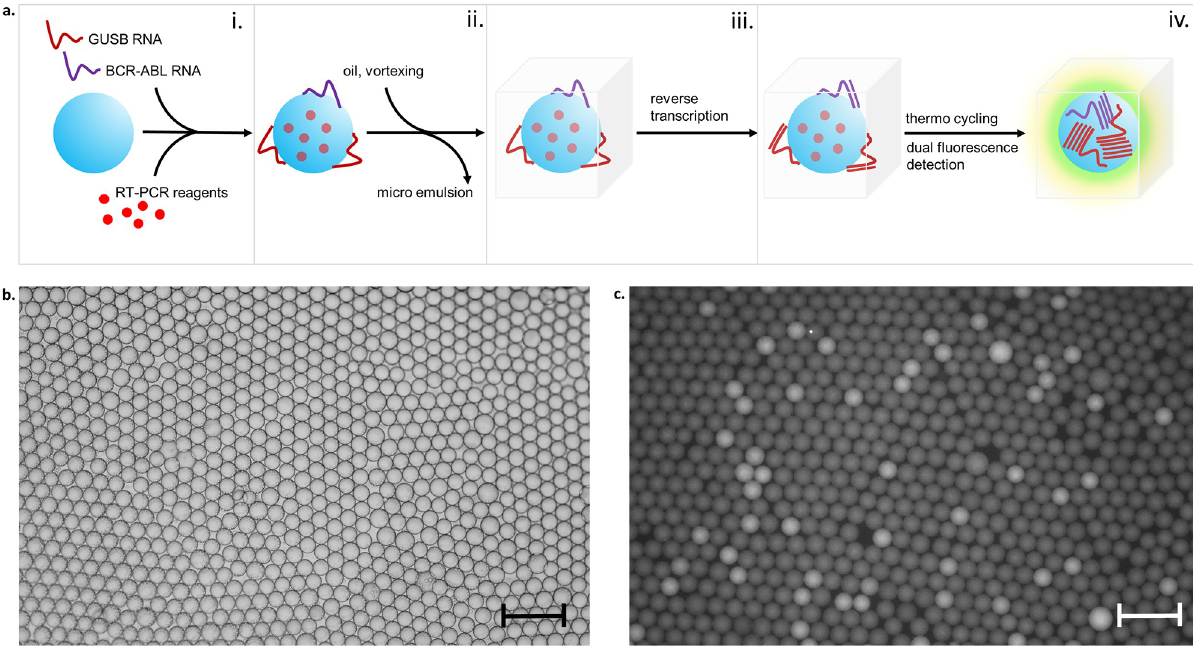
Fig 1. Nanoreactor bead workflow. a, Process steps: i.) nanoreactor bead loading with a solution containing amplification reagents and the extracted nucleic acid, ii.) bead transfer to non-aqueous liquid with a suitable emulsifier, iii.) cDNA synthesis on encapsulated hydrogel bead, iv.) bead melting, PCR and fluorescence detection; b, bright field image of bead nanoreactors in PicoSurf oil; c, fluorescence image of nanoreactor beads post PCR; scalebar = 400 μ m; average diameter of beads was 100 μ m, average volume